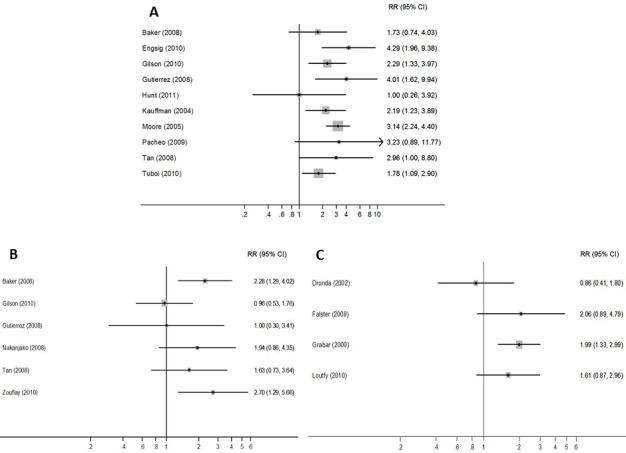
Forest plot showing risk of clinical outcomes for patients with DIR across those studies reporting each outcome: A) Mortality B) AIDS events C) Combined mortality and AIDS events.